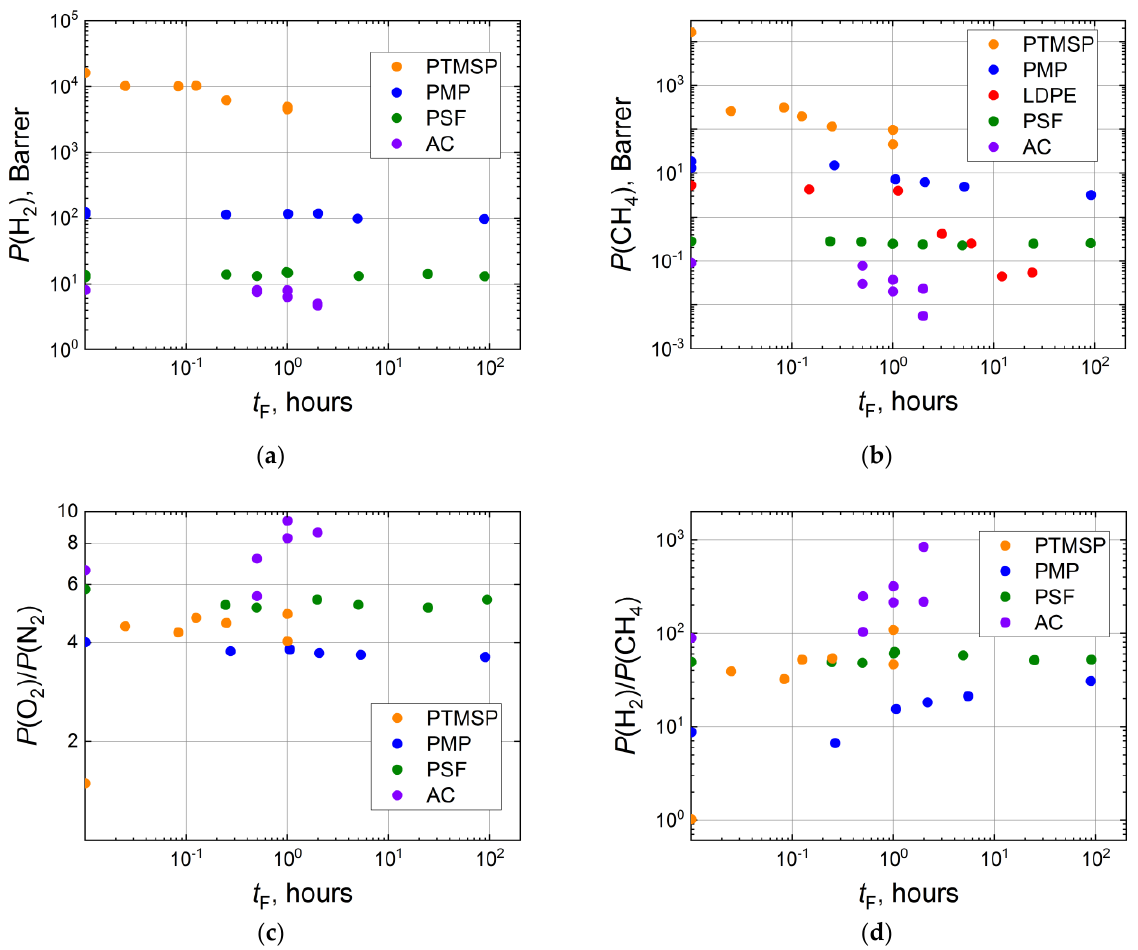
Figure 3. Dependence of H 2 ( a ) and CH 4 ( b ) effective permeability coefficients, ideal selectivities of O 2 -N 2 ( c ) and H 2 -CH 4 ( d ) for the virgin and fluorinated thick-layer membranes (PTMSP [58], PMP [54], PSF [93], AC [65], LDPE [44]) on duration of the fluorination procedure in logarithmic coordinates.